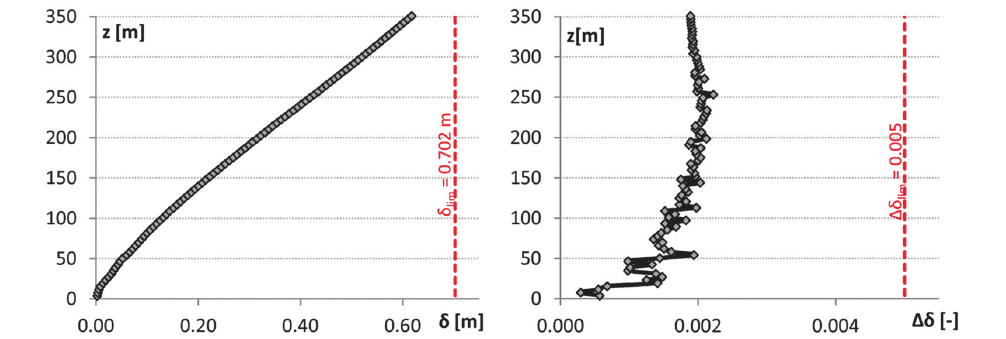
Figure 22: Voronoi building under horizontal loads: lateral displacements, interstory